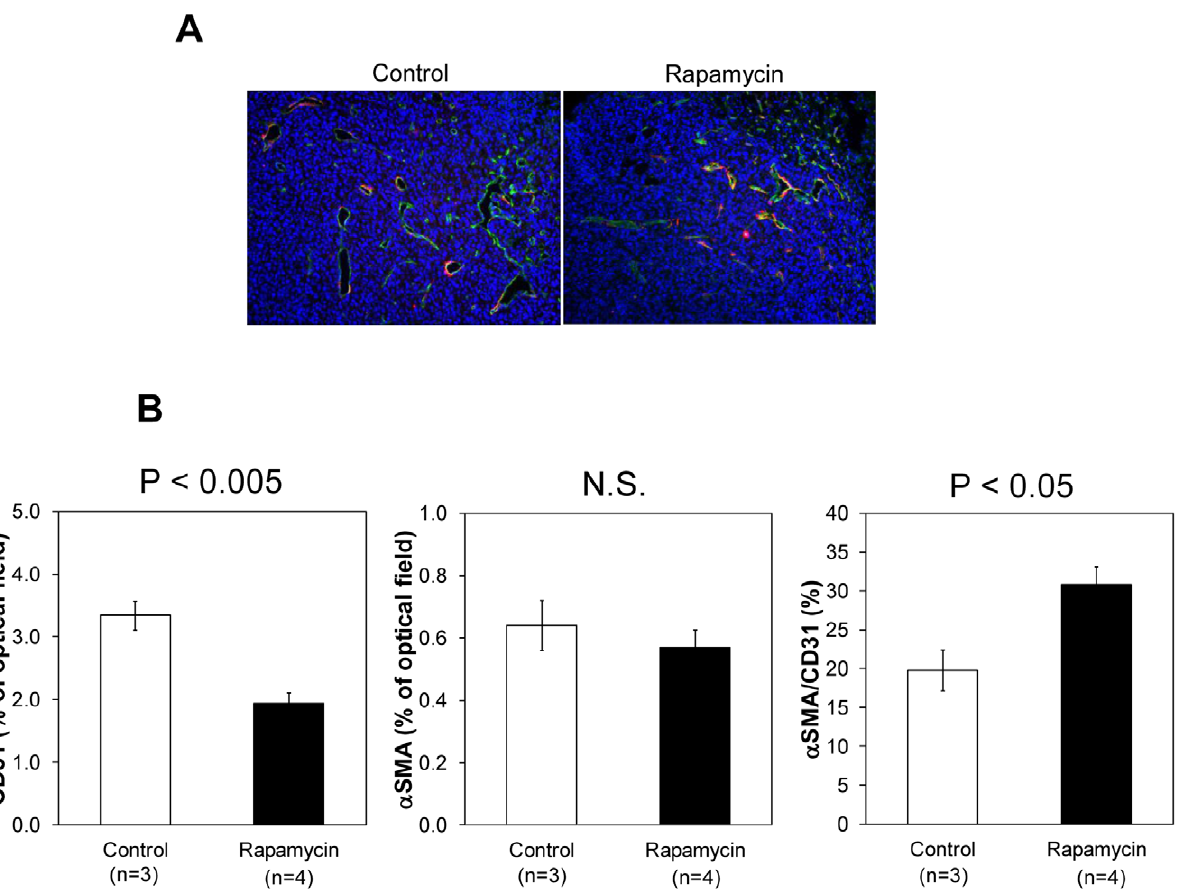
Figure 5. Immunohistochemical analysis of CD31 and a SMA in SCC xenograft. (A) Representative images of control and rapamycin treated SCC xenograft. Green is CD31, red is a SMA, and blue is DAPI. (B) Percentage of CD31 and a SMA in the SCC tumor of control (n=3) and rapamycin treated (n=4, 10 mg/kg bw/day, 2 days) mice.